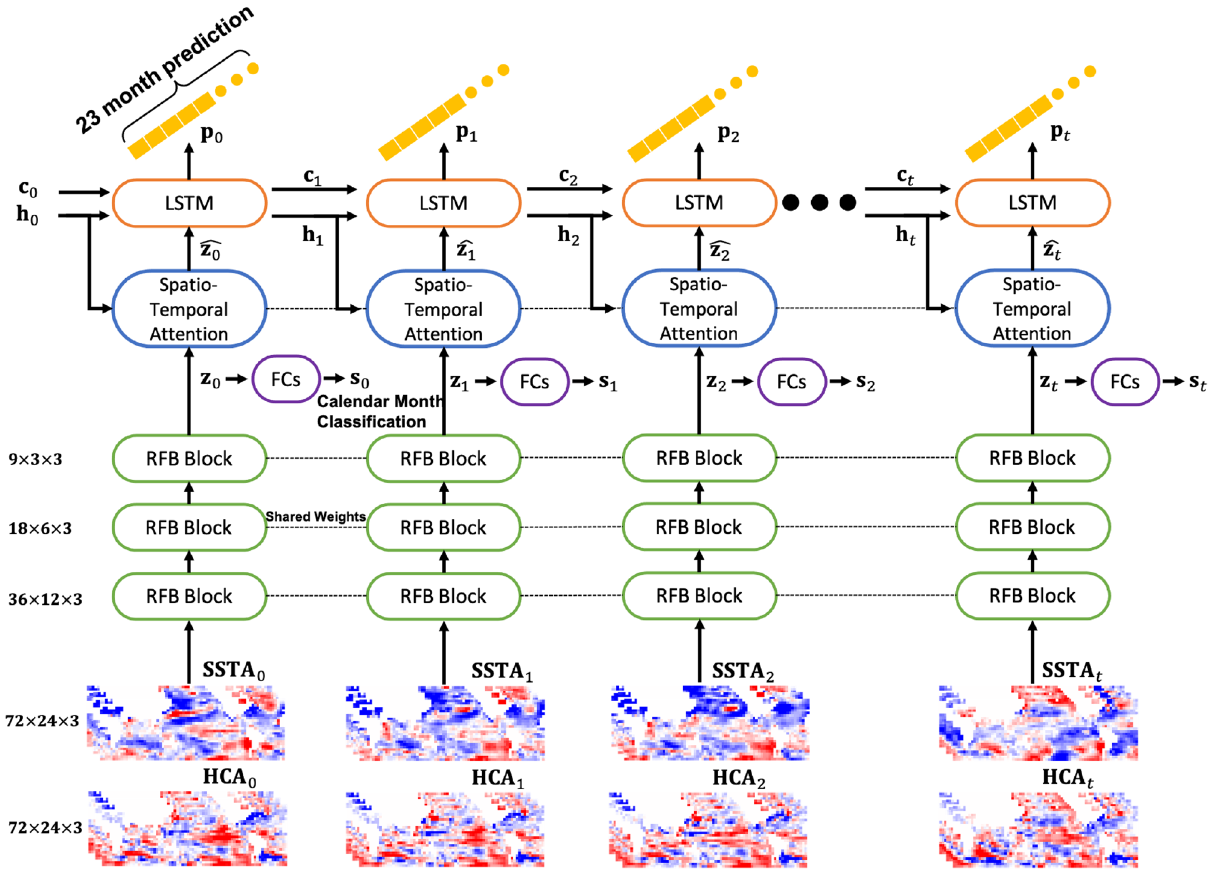
Figure 9. Architecture of the proposed STANet . “FCs” means two sequential fully-connected layers with ReLU and softmax functions respectively for the calendar month classification. “RFB Block” is a receptive field